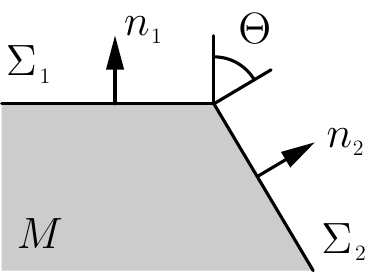
Figure 1. The (cid:12)gure shows the standard situation where a Hayward boundary term must be considered. The spacetime M has a boundary with a non-smooth corner at (cid:0) = (cid:6) 1 described in terms of the angle (cid:2) = cos (cid:0) 1 ( n 1